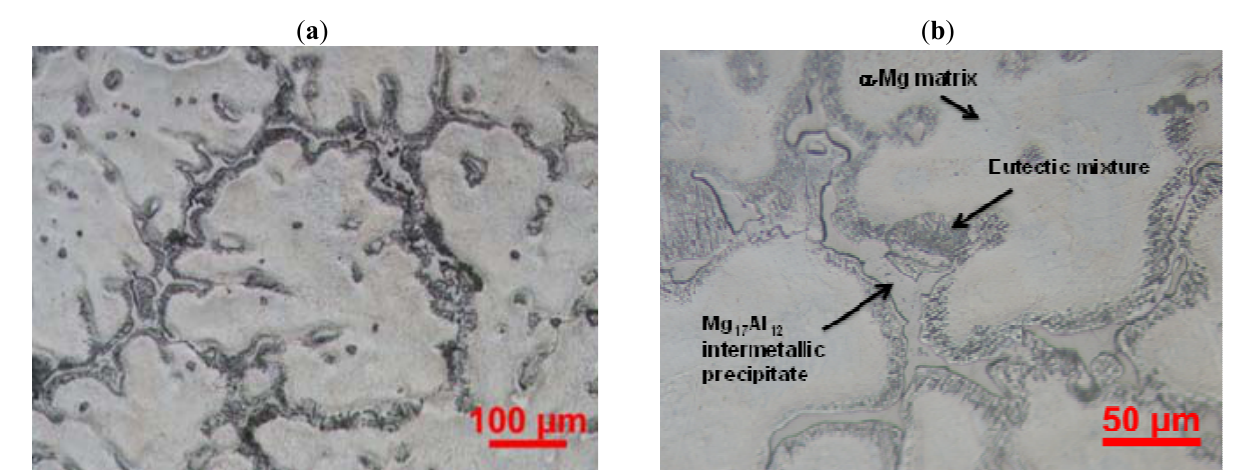
Figure 4. Optical micrographs of AZ91 alloy at two different